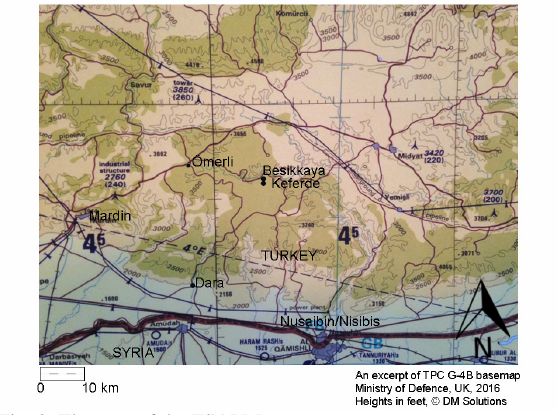
Fig. 2. The area of the FSAPM